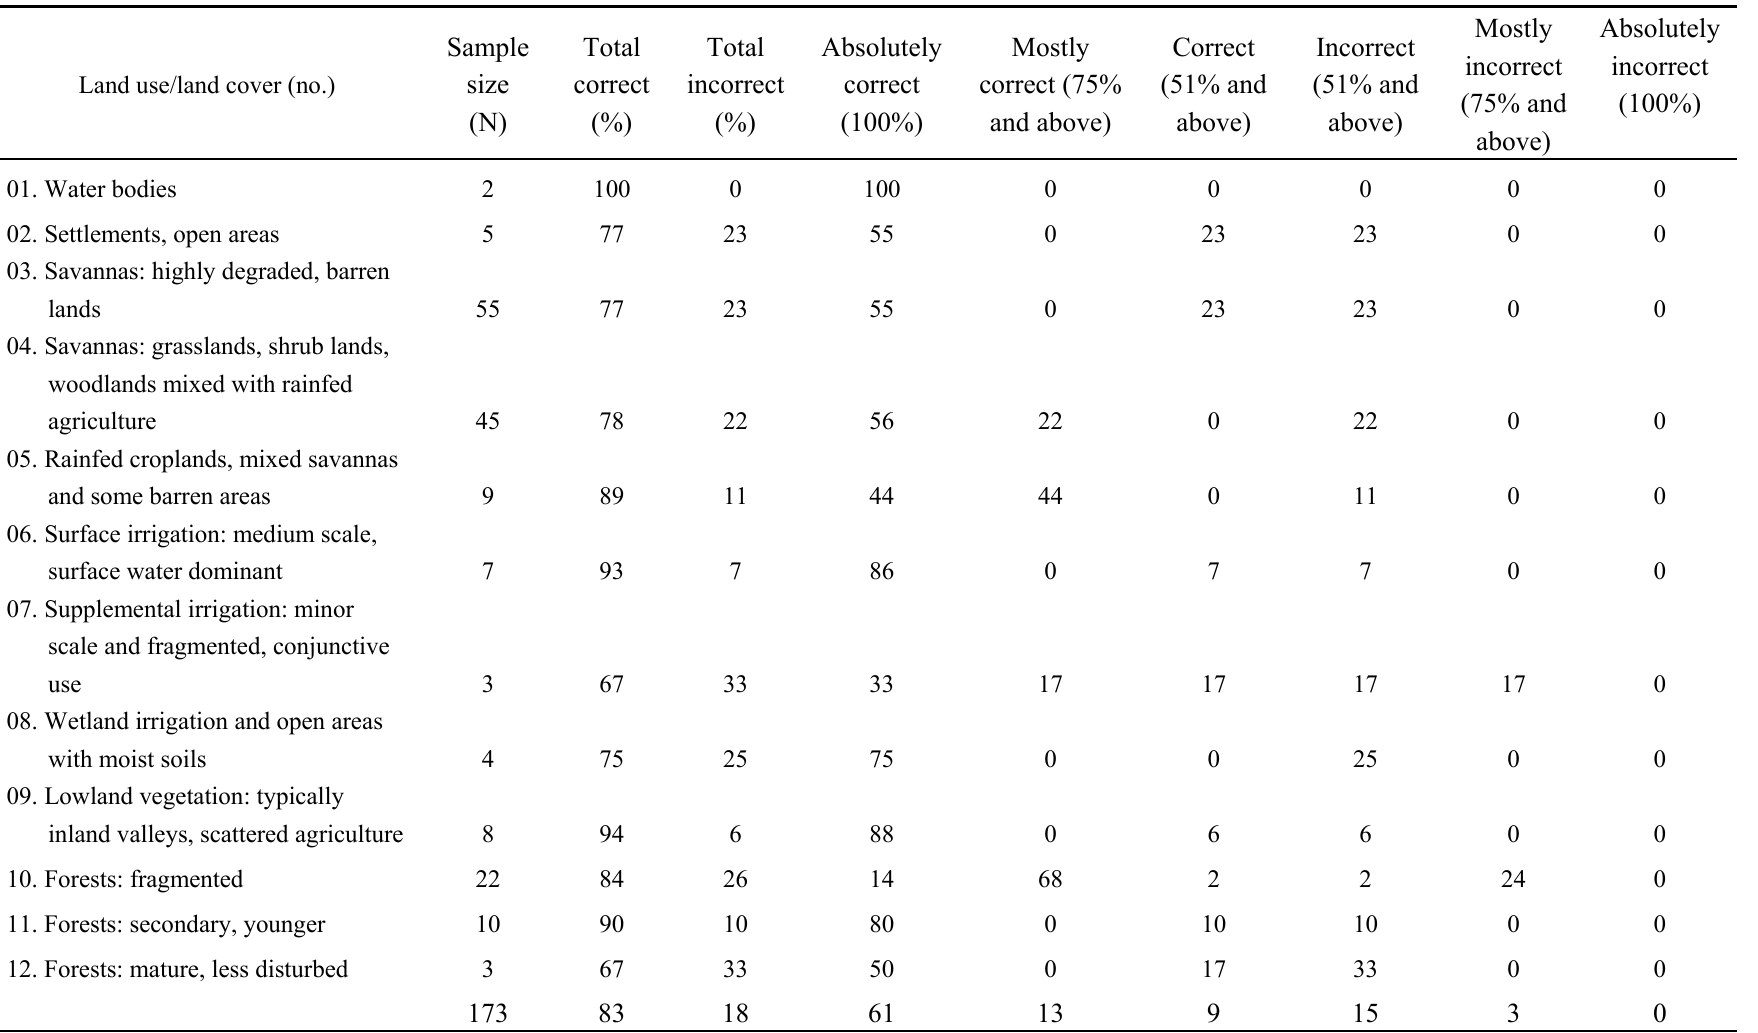
Table 4. Fuzzy accuracy assessment from field-plot data. Numbers in parentheses indicate the fuzzy correctness percentage. Values in the table indicate the % of field-plot windows in each class with a given correctness percentage.